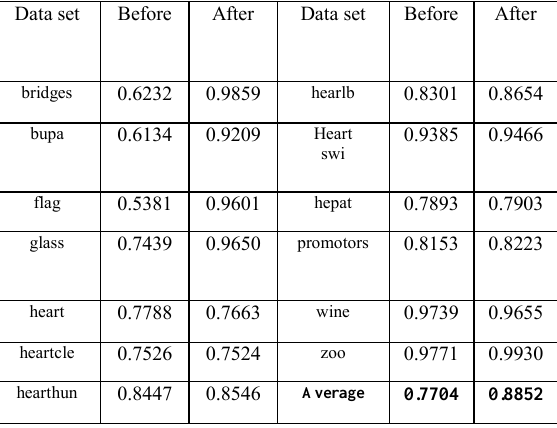
Table 2. Classification before and after embedding